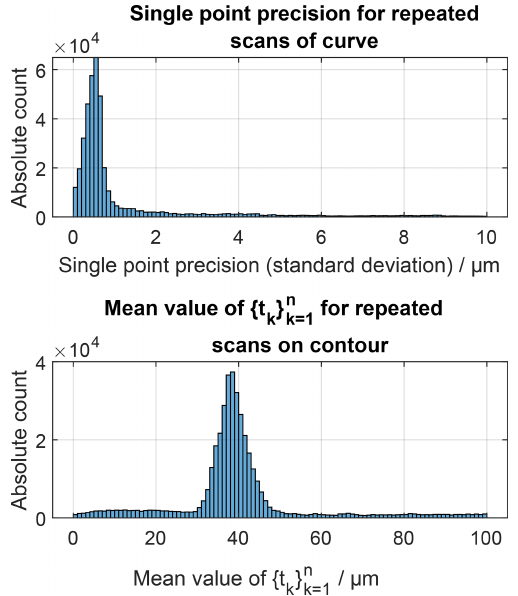
Figure 13. Visualization of the mean values of { t k } n resent the local superposition of the systematic work piece devia- tions and the systematic measurement error. See also the histogram visualization of the shown values in Fig.